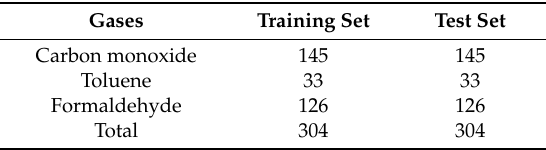
Table 1. Amount of samples in Dataset